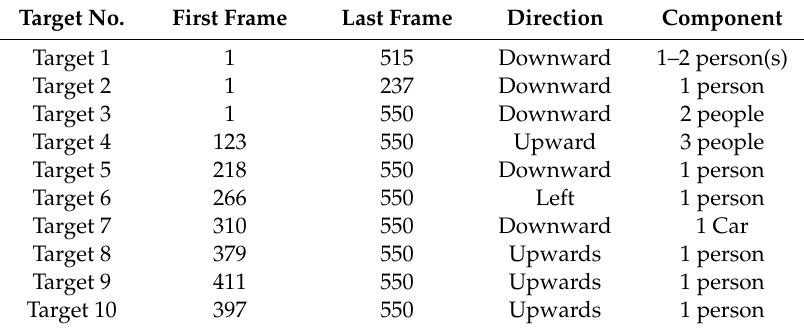
Table 1. Target characteristics.